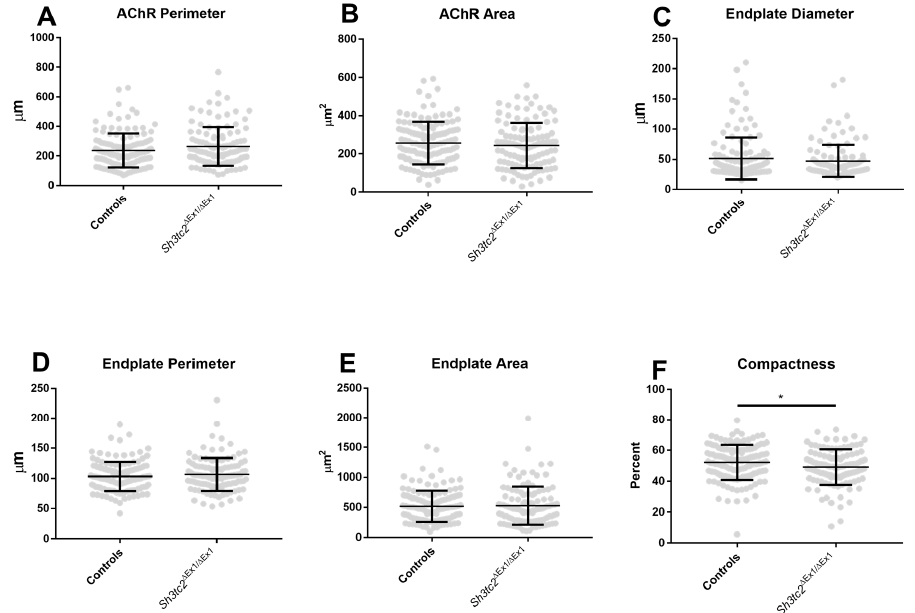
Figure 3. Post-synaptic changes at the endplate of Sh3tc2 Δ Ex1/ Δ Ex1 ( n = 3) versus control ( n = 3) mice: